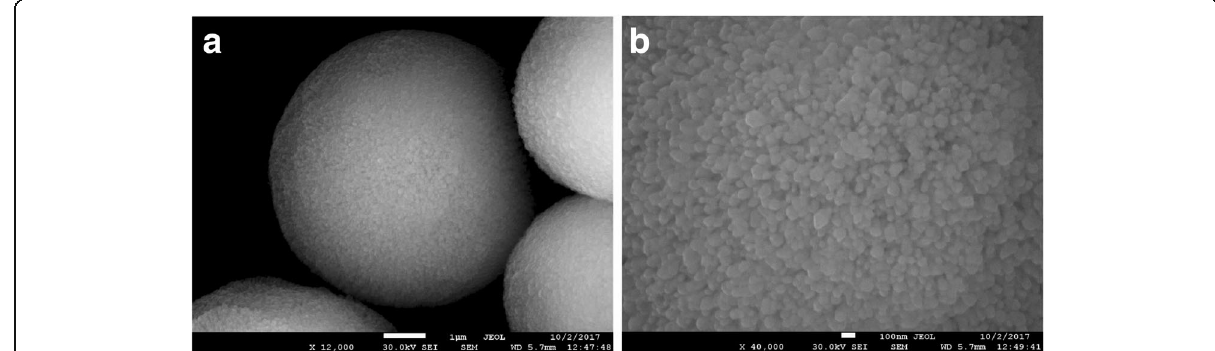
Fig. 1 Scanning electron microphotographs of calcium carbonate microparticles ( a ) and their surface at a higher magnification ( b